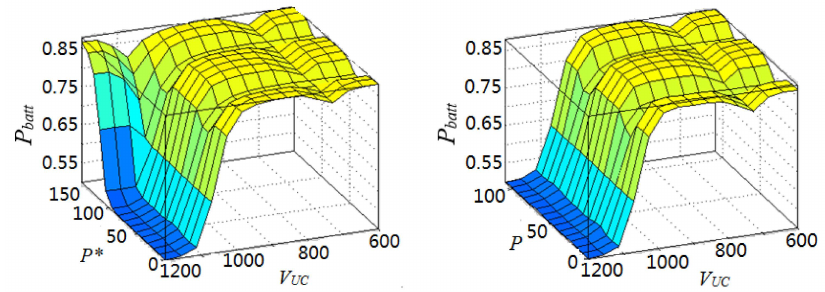
Figure 20. The relationship between the input and output of mode